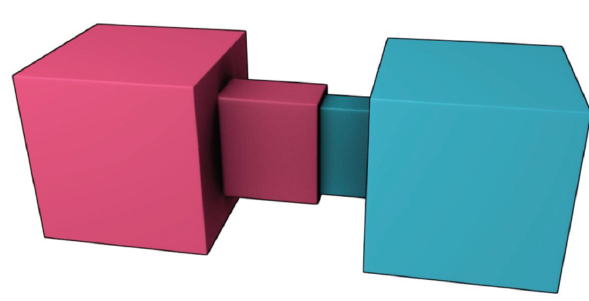
Figure 6: A horizontally aligned prismatic joint (Coumans, 2014).